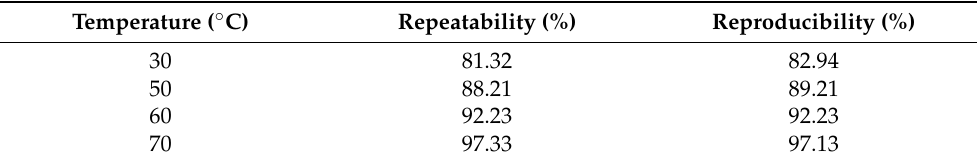
Table 1. Repeatability and reproducibility of the HPLC-SEC method at different temperatures.